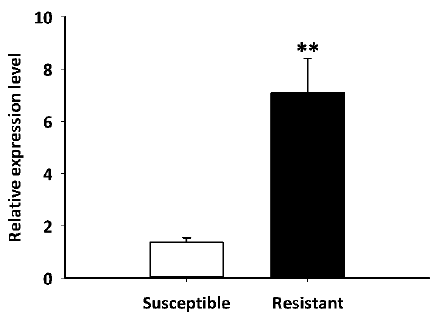
Figure 7. Expression patterns of LdGSTu1 in resistant and susceptible strain. The “**” indicates significant differences in gene expression at p < 0.01, according to independent Student’s t -test.